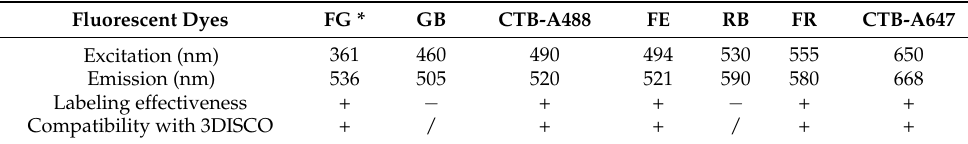
Table 1. Selection of fluorescent